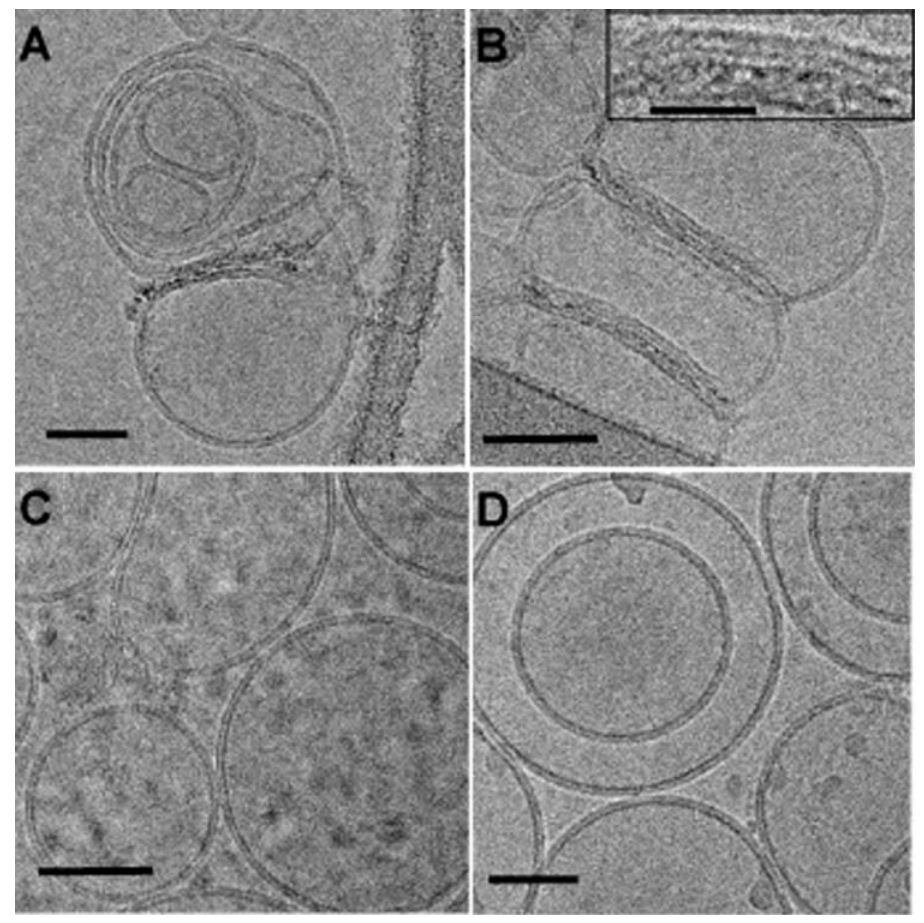
Figure 4. LUV aggregation and deformation by Penetratin as a function of lipid composition. LUV of different composition in the presence of Penetratin were observed by cryo-electron microscopy. PC (A), PC/PG (9/1) (B), SM/Chol (1/1) (C), and SM/Chol/PG (4/5/1) (D). Bars 50 nm. Inset in B shows an amplification of the Penetratin membrane bridges. Notice the perturbation of the phospholipid bilayer. Bar for inset 20 nm.